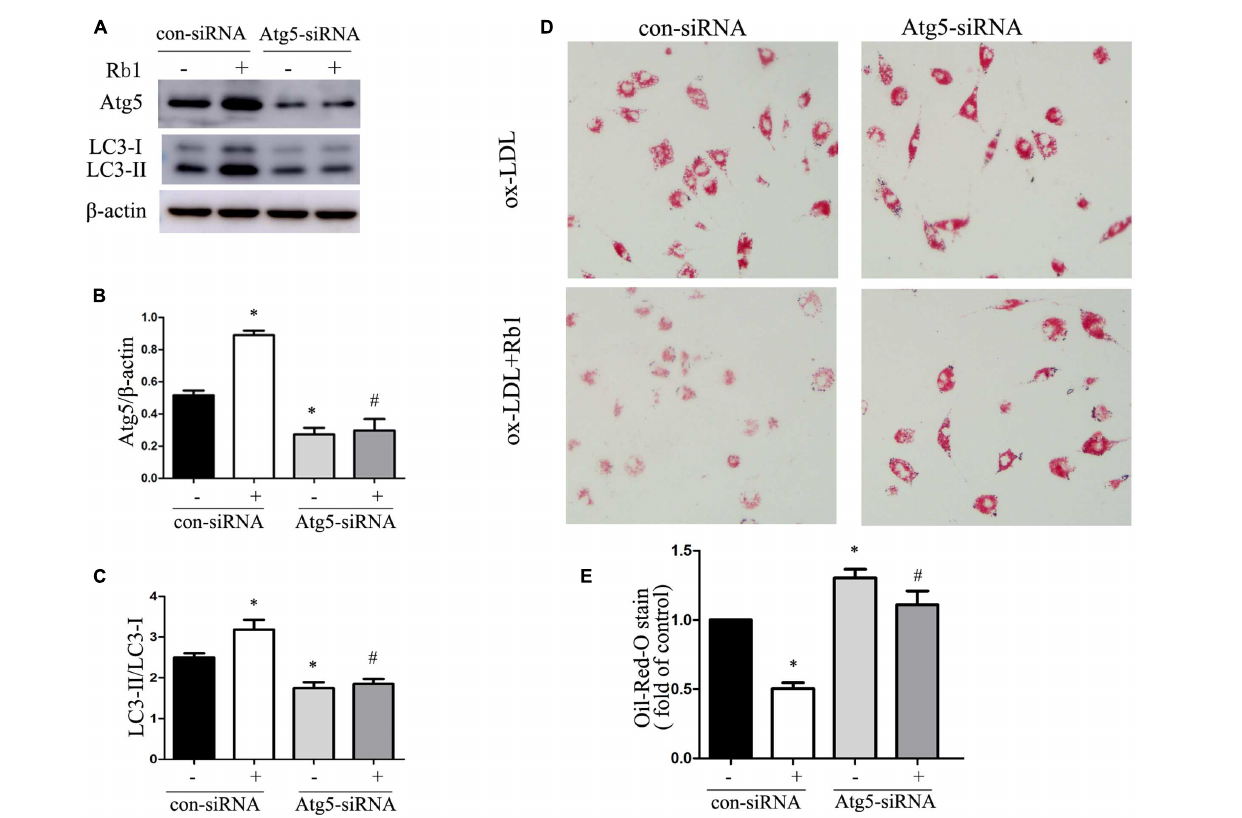
FIGURE 3 | Rb1 reduced lipid accumulation of macrophage foam cells by autophagy induction. Primary peritoneal macrophages were transfected with con siRNA or Atg5 siRNA and then treated with ox-LDL (100 µ g/ml) in the absence or presence of 20 µ M Rb1. (A) Representative western blot analysis of Atg5 and LC3. (B) Quantification of Atg5 and (C) LC3 expression relative to β -actin in macrophages with different treatments. (D) Lipid accumulation in macrophages transfected with Atg5 siRNA with or without Rb1 treatment. (E) Quantitative analysis of lipid accumulation. ∗ p < 0.05, compared to con siRNA; # p < 0.05, compared to con siRNA + Rb1, n =